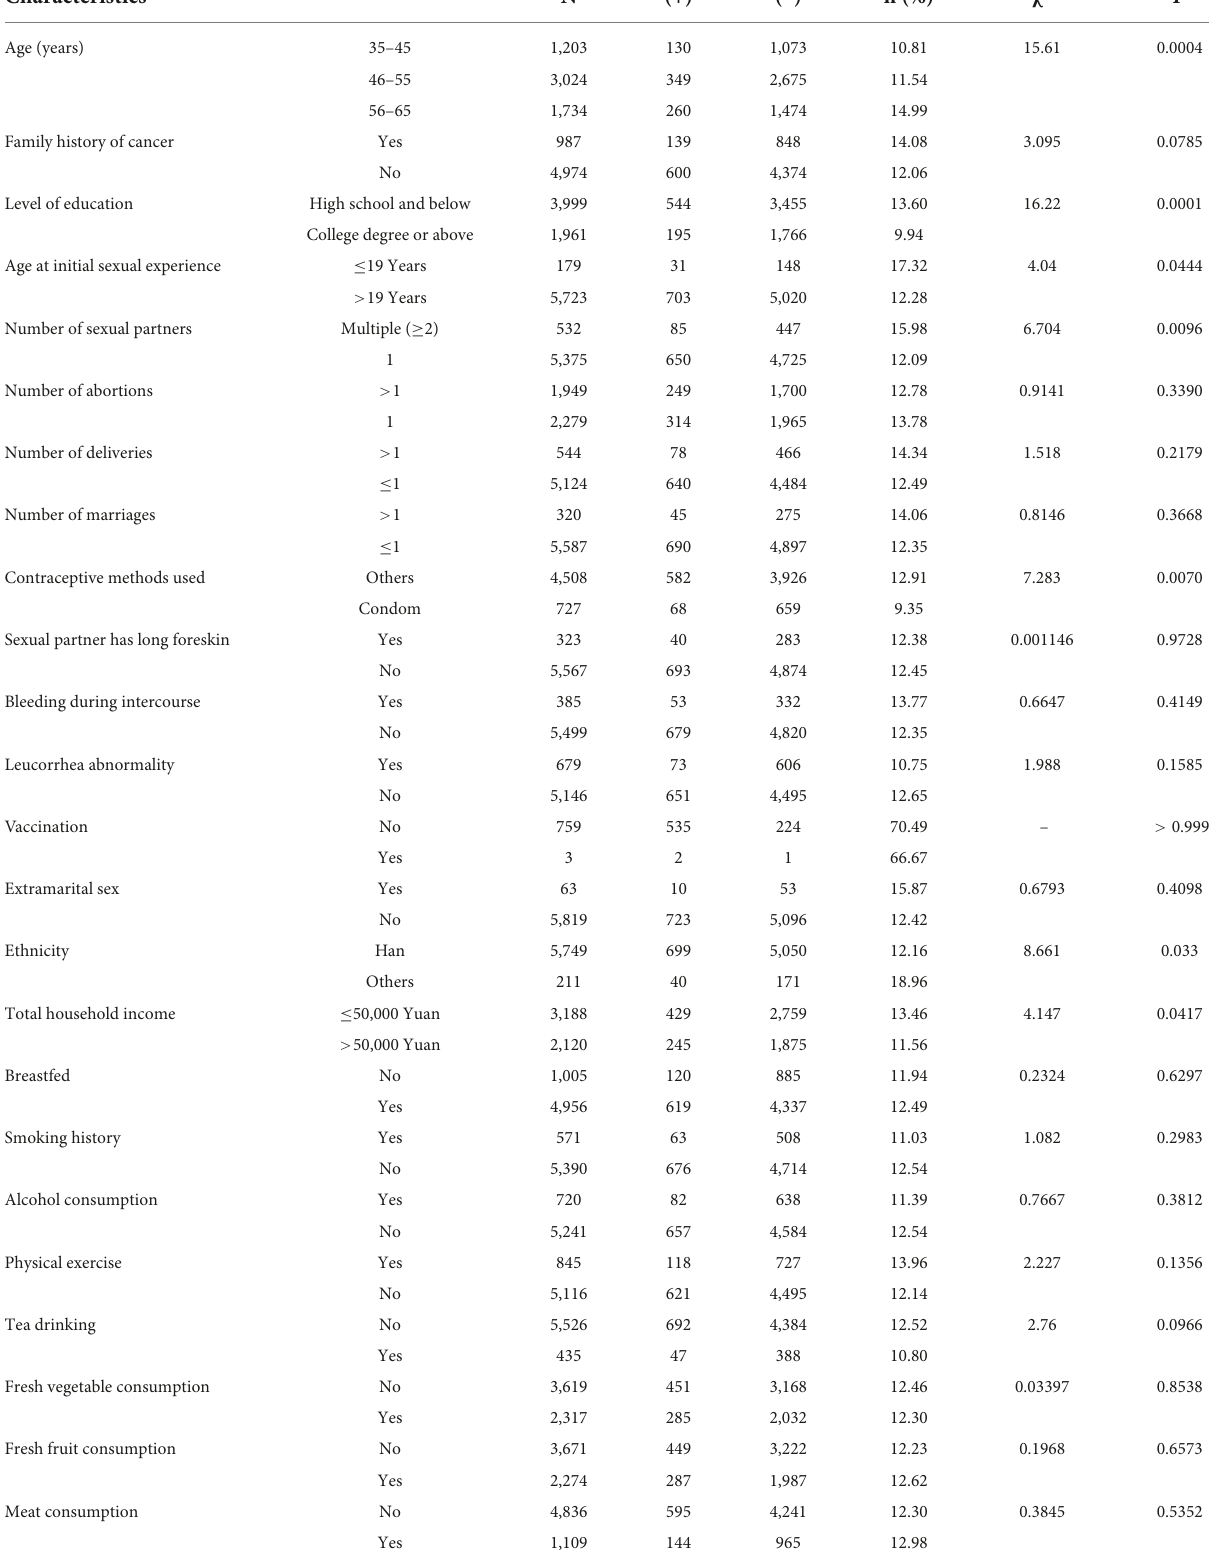
TABLE 11 Comparison of information and living habits of women with a positive HPV detection rate.